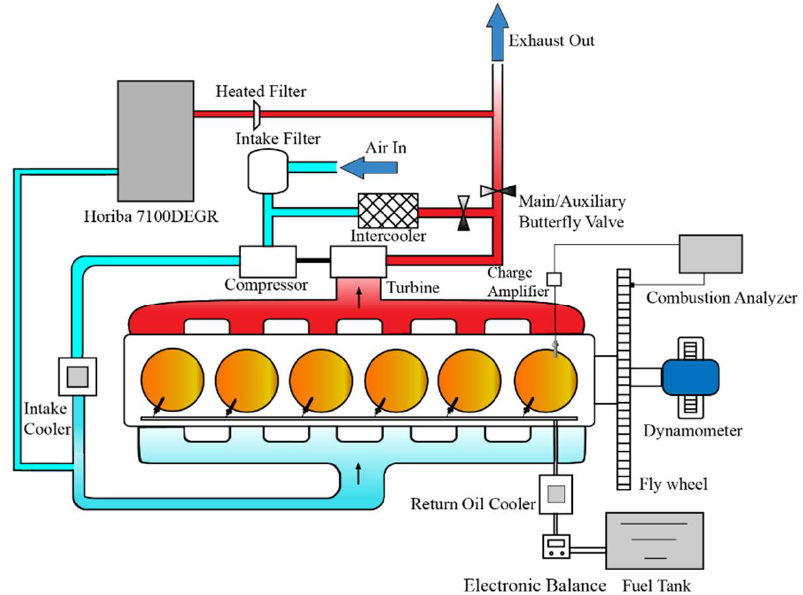
Figure 4. Schematic diagram of the experimental setup.